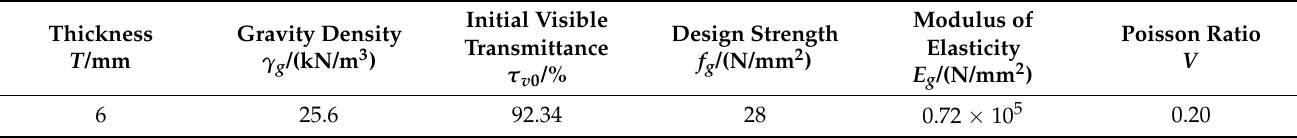
Table 1. Basic information of glass.